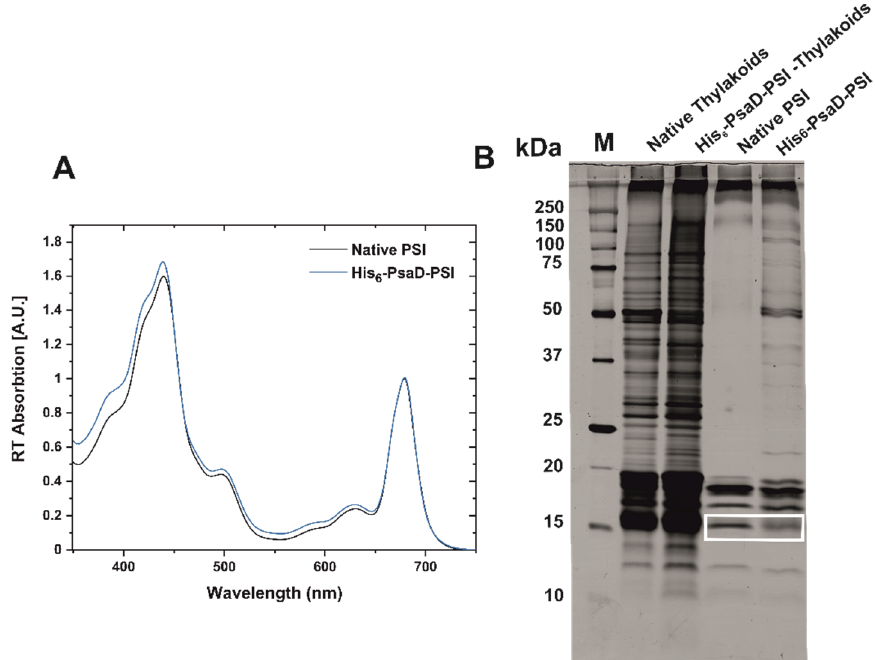
Figure 2. Biochemical characterization of the native PSI and His 6 -PsaD-PSI from C. merolae . ( A ) RT Absorption spectra of the native (black) and His 6 -PsaD-PSI (blue) complexes. ( B ) SDS-PAGE analysis of the native (thylakoids and WT PSI) and modified (thylakoids and His 6 -PsaD-PSI) proteins. The bands corresponding to the His 6 -tagged PsaD and native PsaD proteins are marked with a white box.